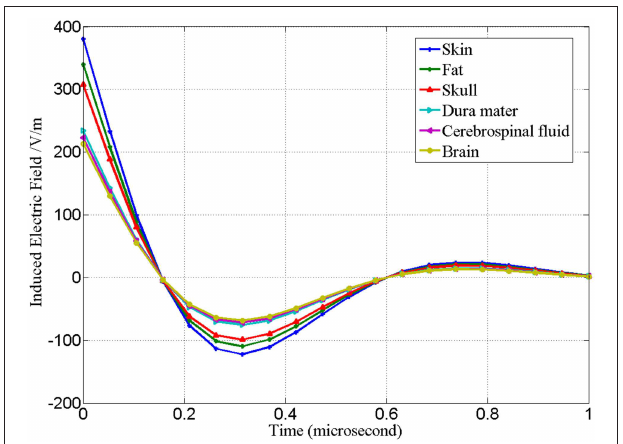
FIGURE 8 | Waveform of the induced current density of the upper surface of brain tissues at the central projection of “figure-of-eight coil” changing with time.